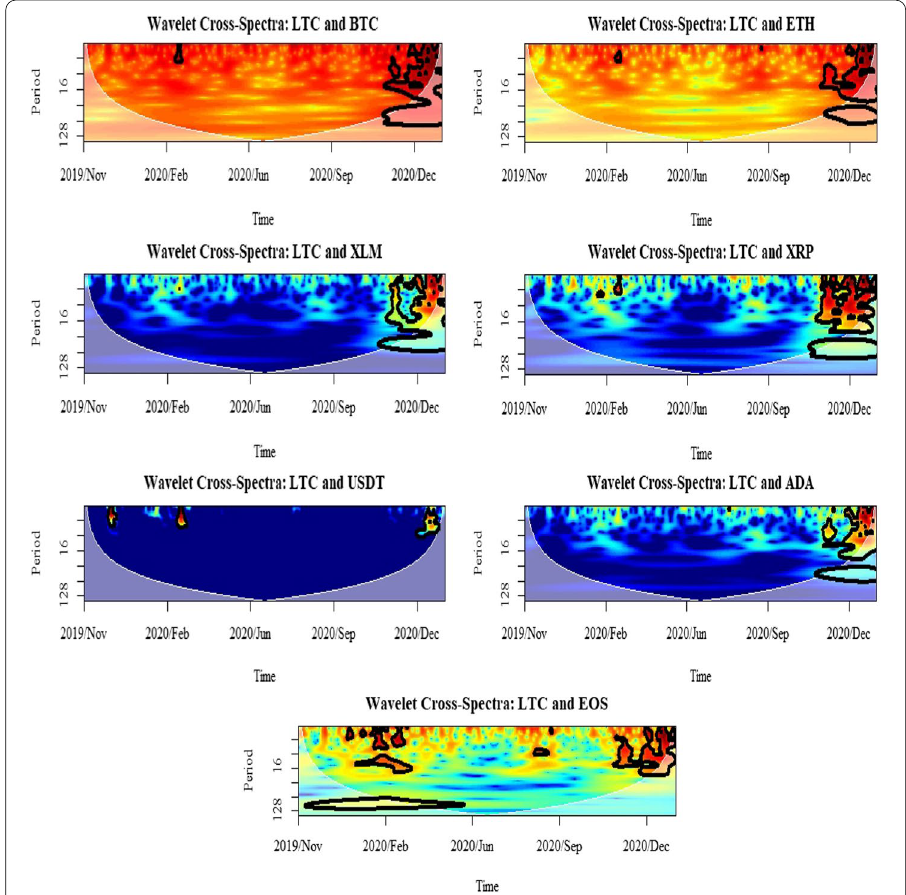
Fig. 11 Results for wavelet cross-spectra: LTC